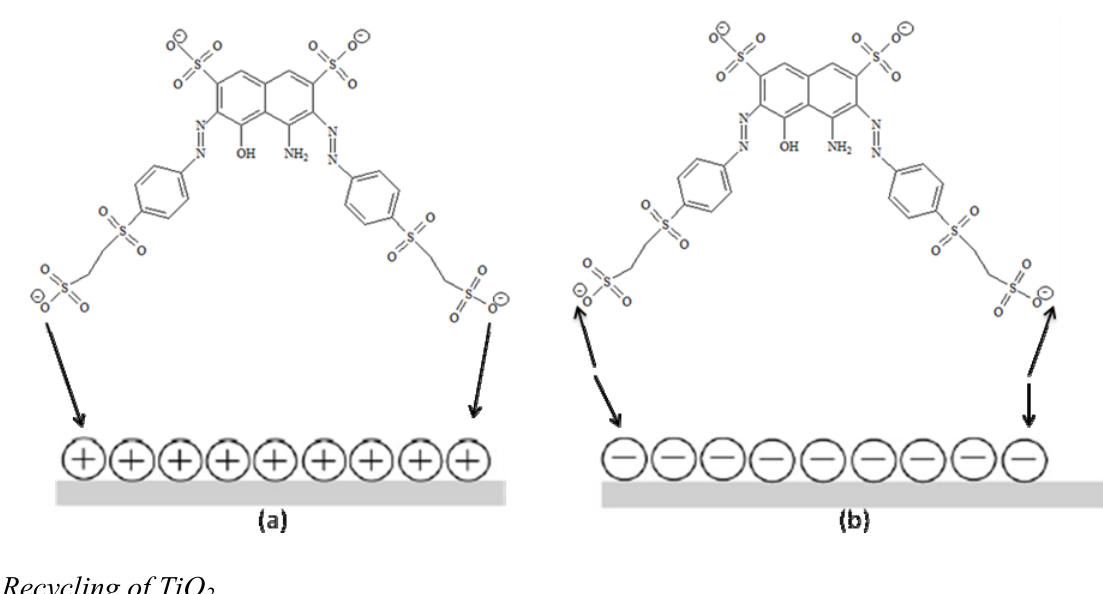
Figure 6. Schematic interaction model of C.I Reactive Black 5 and TiO (b) basic